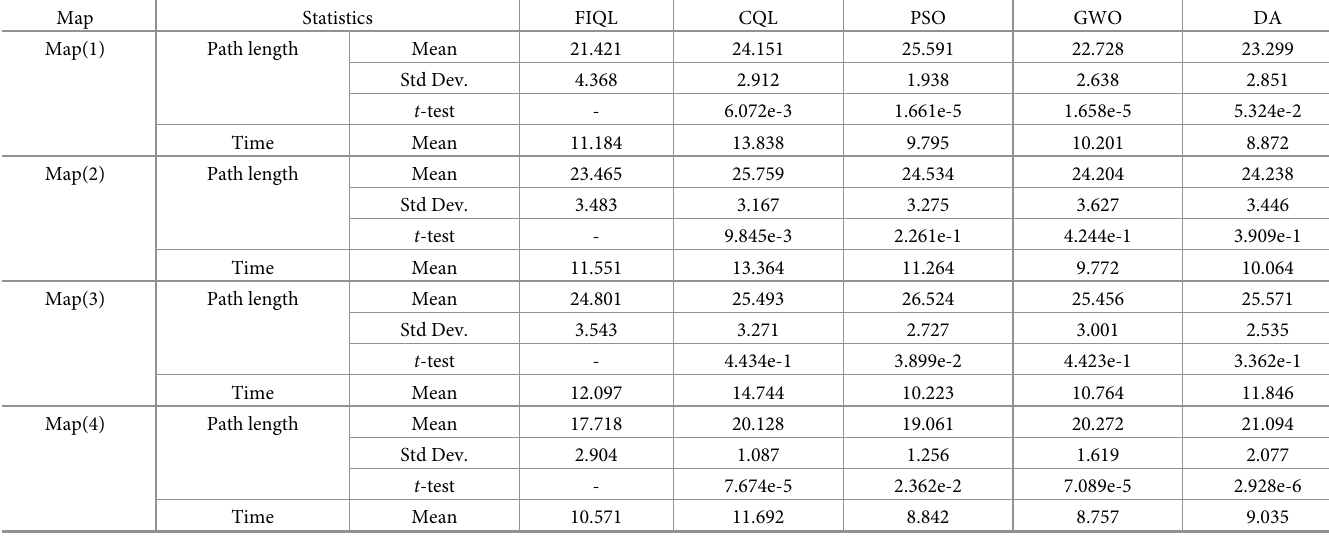
Table 3. Comparison between FIQL, CQL, PSO, GWO and DA in improved grid